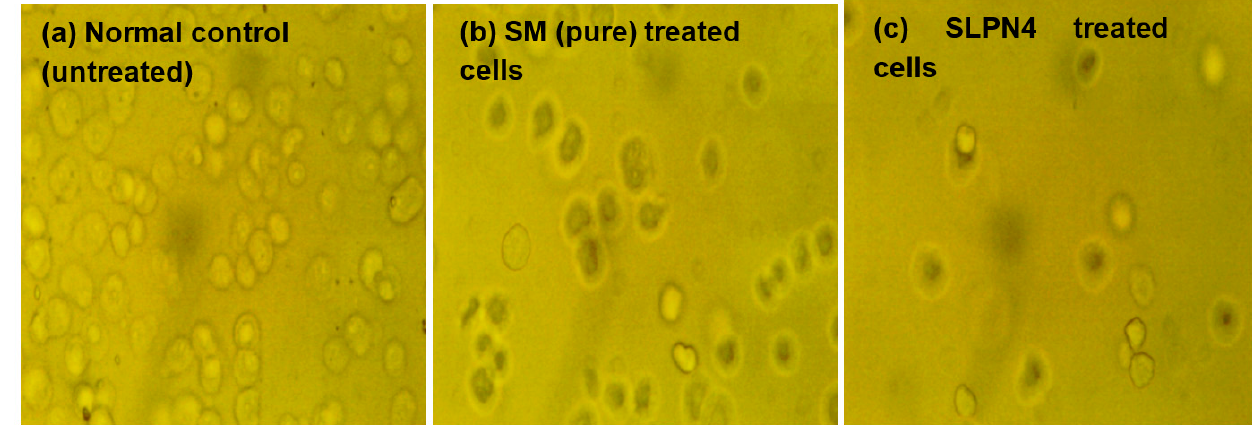
Figure 9. Morphological changes in MCF7 cells after exposure to Sunitinib-containing formulations. Untreated cells/control, cells incubated with pure SM, and SLPN4.